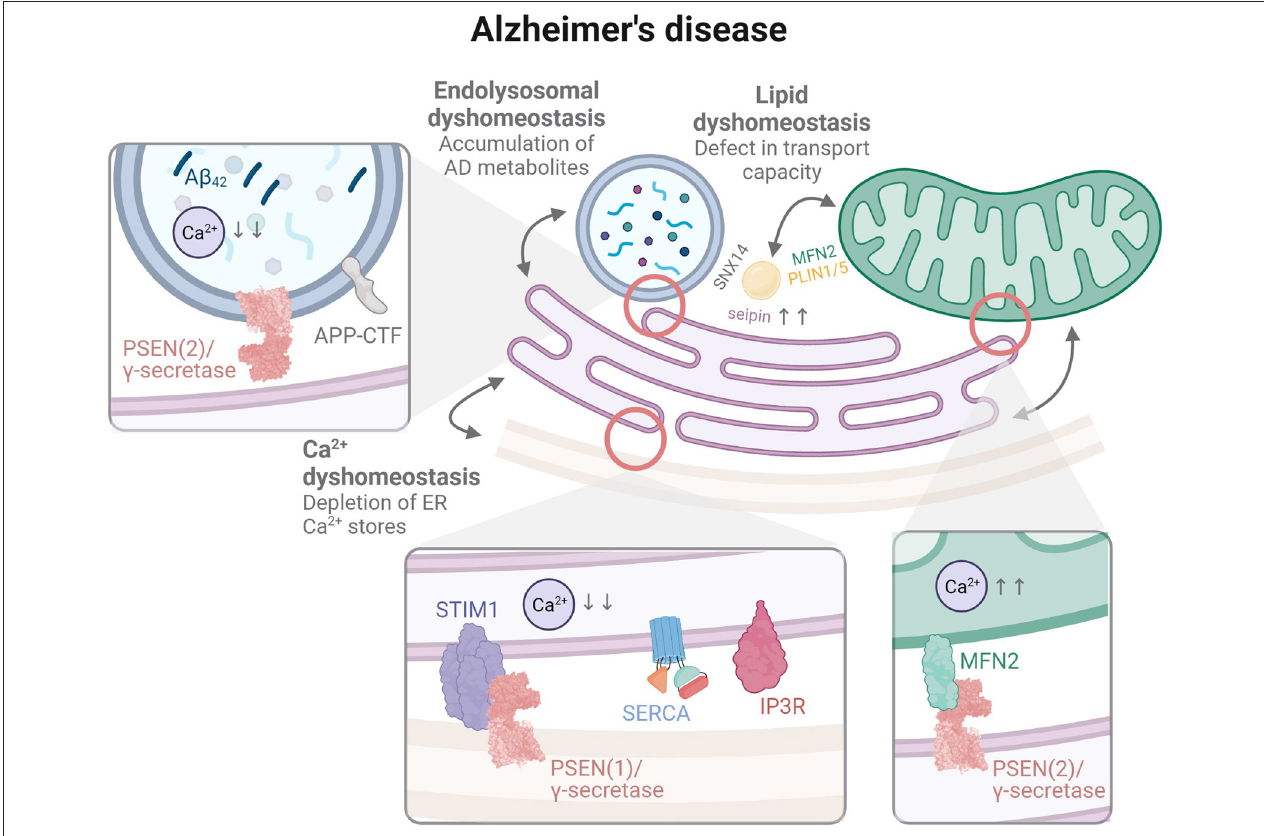
FIGURE 3 | The organelle interactome in AD. Contact sites between the ER and mitochondria (MAM) were linked to a physical interaction between MFN2 and PSEN2/ γ -secretase, while ER-LE/Lys contacts may represent a primary root for organellar disruption through the generation of aggregation-prone A β in LE/Lys by PSEN2/ γ -secretase. The illustrated observation that lysosomal Ca 2 + is disrupted in AD supports this hypothesis. Contacts between the ER and the plasma membrane are additionally represented in order to illustrate disruption of Ca 2 + homeostasis involving the capacitative SOCE mechanism, with a suggested interaction between PSEN1/ γ -secretase and